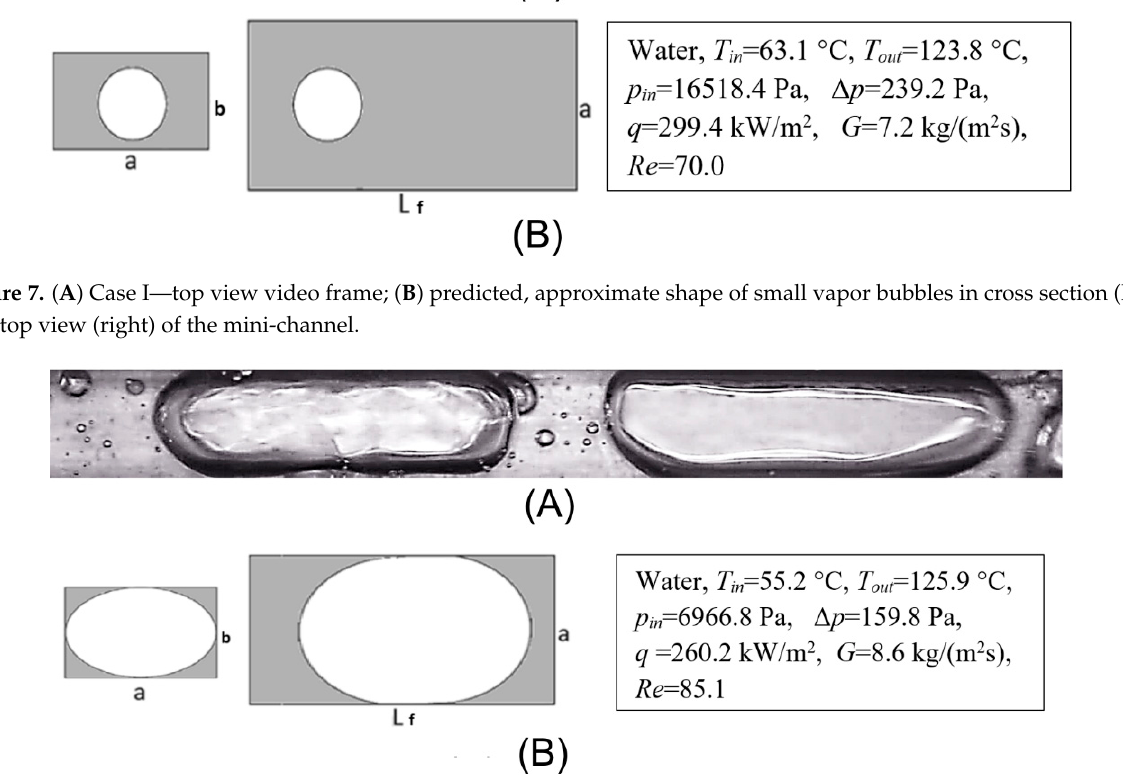
Figure 8. ( A ) Case II—top view video frame; ( B ) predicted, approximate shape of elongated, fully visible vapor bubble in cross section (left) and top view (right) of the mini-channel.